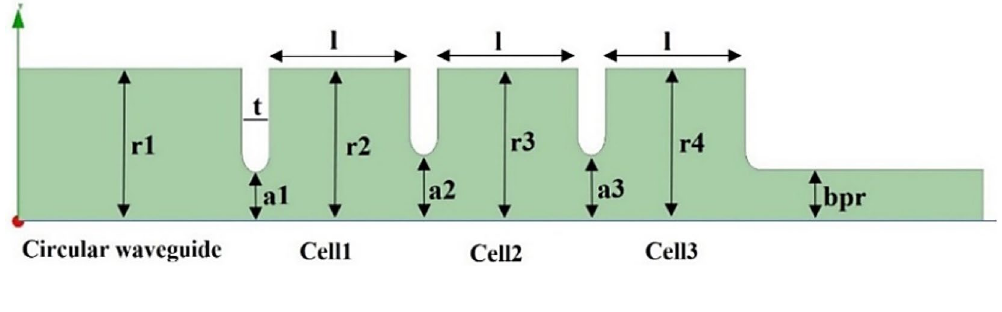
Figure 2. The structure of designed